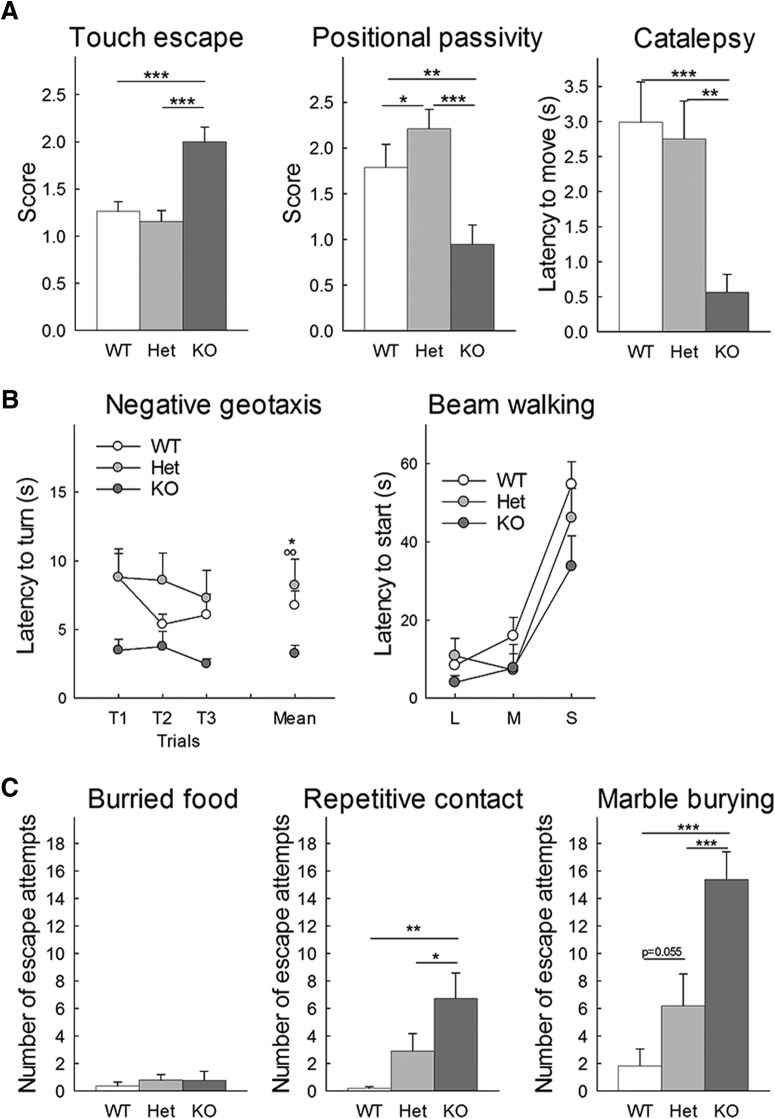
Hyper-reactivity and escape behavior in Shank3Δ4-22-deficient mice. A, Hyper-reactivity measured by animal response in touch escape, positional passivity, and catalepsy. Shank3Δ4-22 homozygous mice have hyper-reactive responses as shown by a higher score in the touch escape indicating an escape response to lighter strokes, a lower score in positional passivity indicating that they struggle more when restrained, and a lower latency to get off a rdownod in the catalepsy test. B, Impulsivity in the negative geotaxis and beam walking tests. The latency to start turning in the negative geotaxis test and to start crossing in the beam walking test are significantly lower in Shank3Δ4-22 homozygous mice compared to their wild-type and heterozygous littermates and often associated with higher failure rates (data not shown) thus demonstrating impulsive behavior. C, Escape behavior measured in different tests with increased inanimate object exposure. No escape attempts were observed for any genotype during the habituation phase of the buried food test (empty home cage with clean bedding). Object exposure induced a significant escape behavior in Shank3Δ4-22 homozygous mice with a number of attempts increasing with the number of objects in the cage (same home cage, four objects in the repetitive novel object contact task, 20 objects in the marble burying test). Very little escape attempts were observed in wild-type mice, while an intermediate phenotype was observed in heterozygous mice. WT, wild-type mice; Het, heterozygous mice; KO, homozygous knock-out mice. *: WT vs KO; o: WT vs Het. *p < 0.05, **p < 0.1, ***p < 0.001.